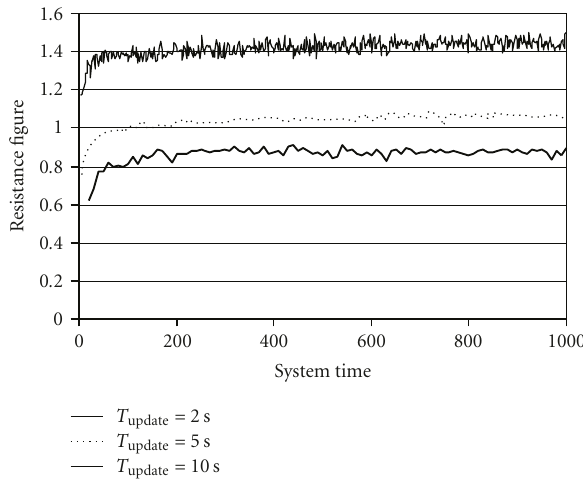
Figure 7: Resistance figure under di ff erent values of T update